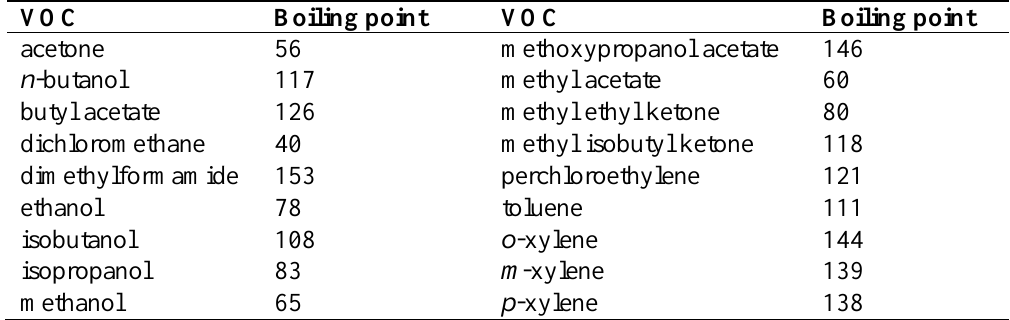
Table 2. Model VOCs used in the experiments.